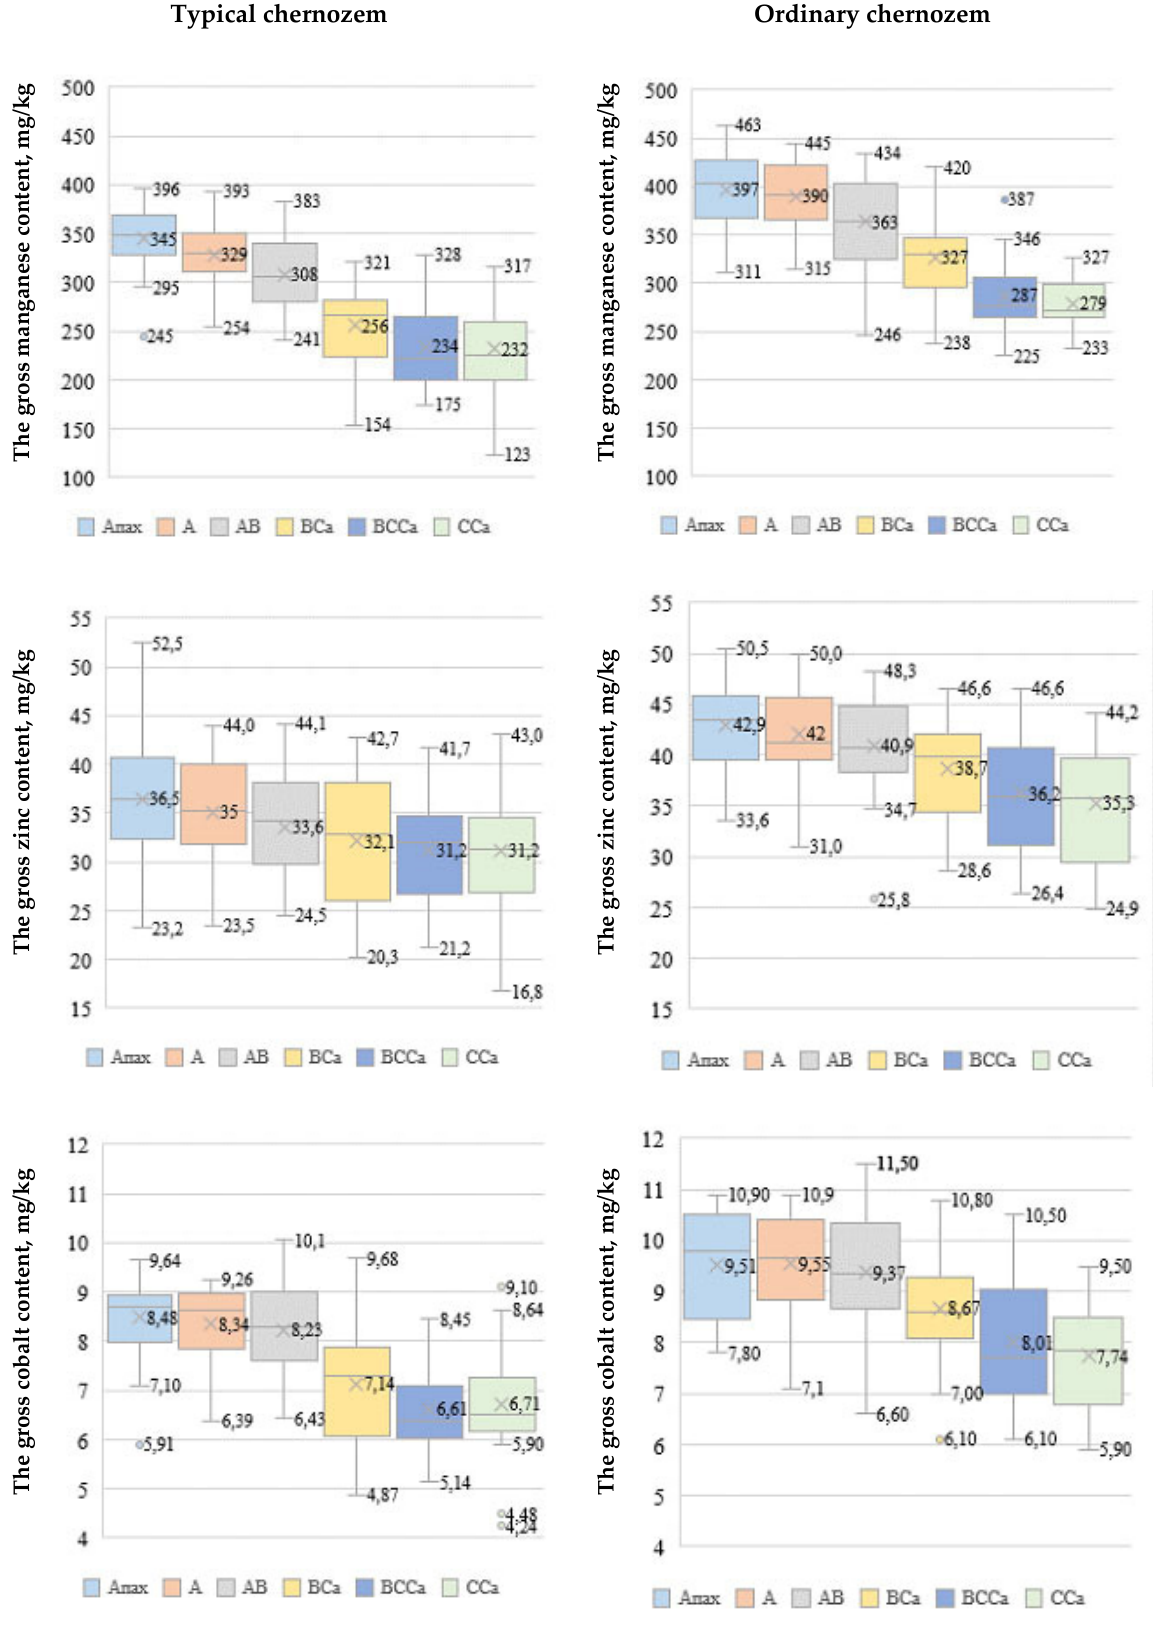
Figure 2. The gross contents of trace elements in soil profiles of typical and ordinary arable cherno- zems.